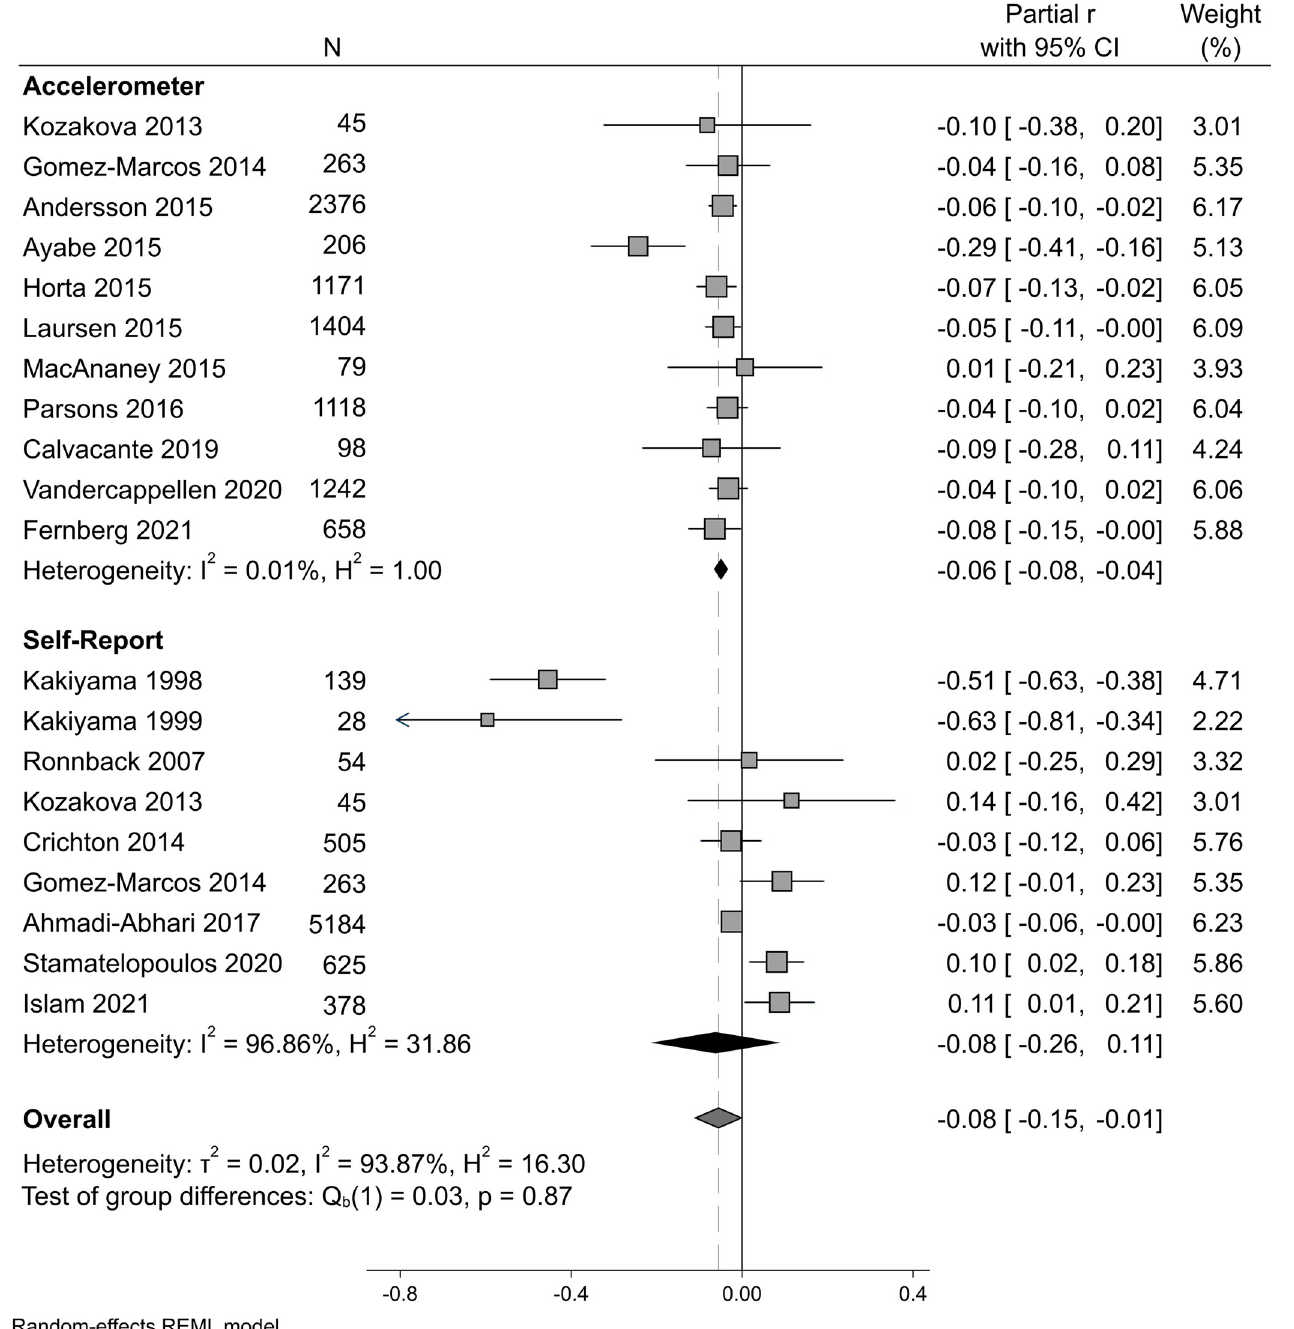
Fig 2. Forest plot of pooled analysis indicating the association between habitual moderate-vigorous or total physical activity and carotid-femoral pulse wave velocity, grouped by physical activity measurement method. Random effects model. Grey squares indicate individual study association with 95% confidence intervals (CI). Solid vertical line represents line of no difference. Dashed vertical line and grey diamond represents the overall summary estimate of association. Black diamonds represent the individual subgroup overall effect size.